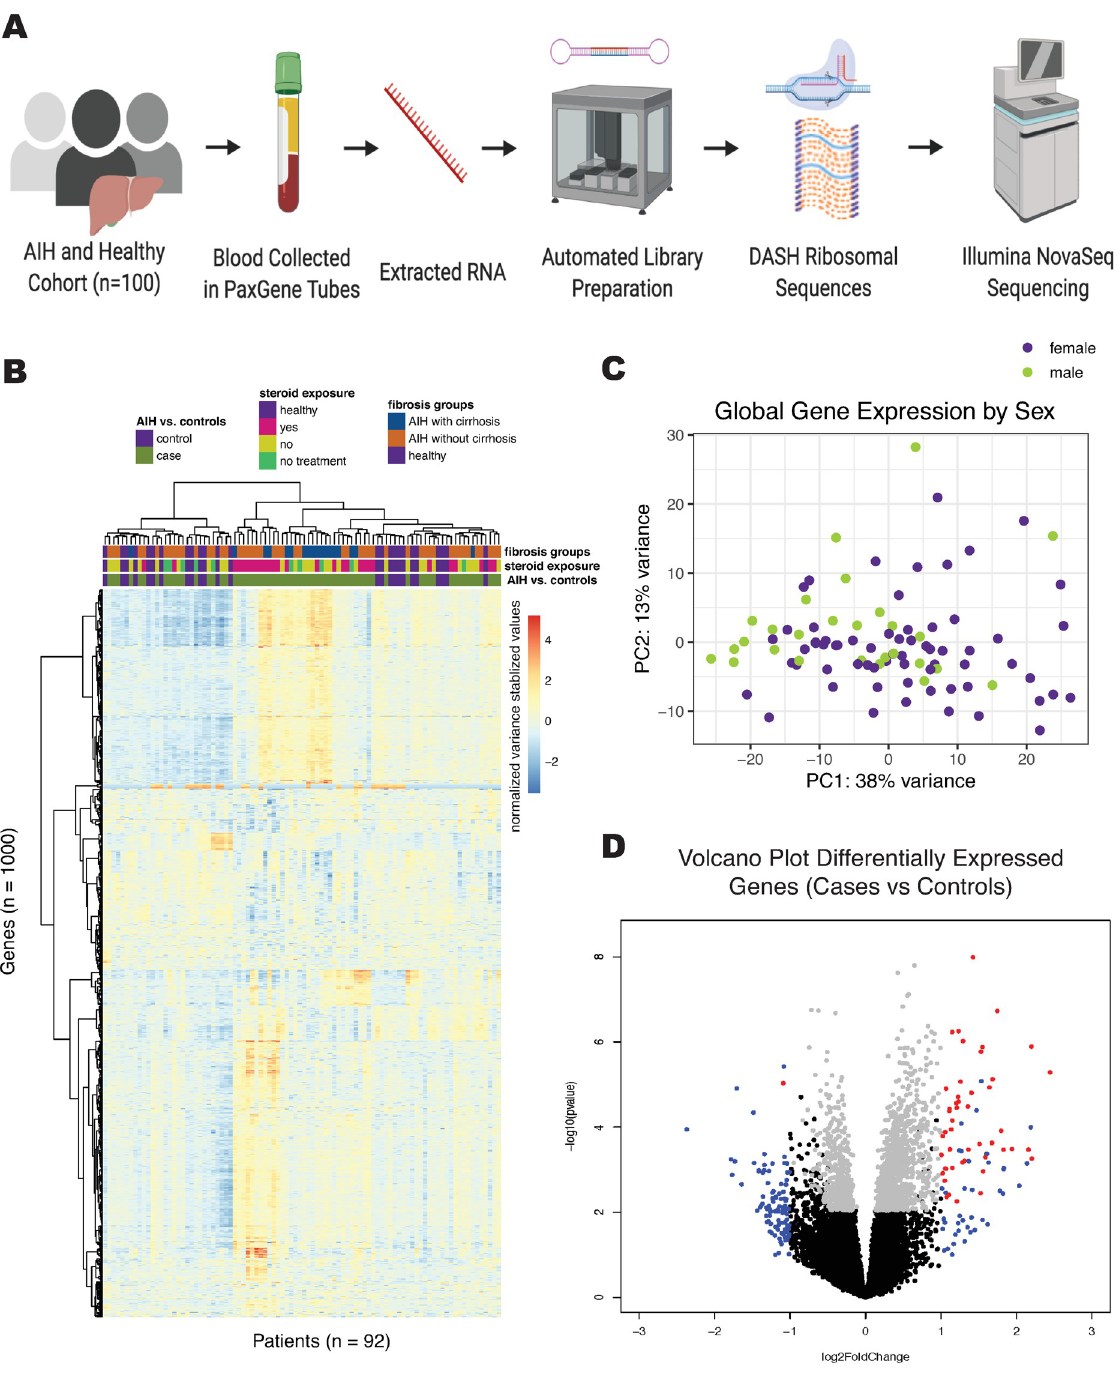
Fig 1. A. Schematic of sample processing for library preparation of whole blood for AIH cohort. B. Heat map displaying gene counts (variance stabilizing transformation, see DESeq2) of the top 1000 genes with highest variance amongst samples. Samples are clustered on the x-axis and protein coding genes are clustered on the y-axis using a Ward D2 method. Relevant metadata included patient status, steroid exposure, and fibrosis groups to classify samples. C. PCA plot of variance stabilizing transformed gene counts colored by sex of patient sample. D. Volcano plot of differential gene expression in DESeq2, showing genes with P < 0.05 and log fold change > 1 in red, and genes with only log fold change > 1 in blue, and genes with only P < 0.05 in grey.